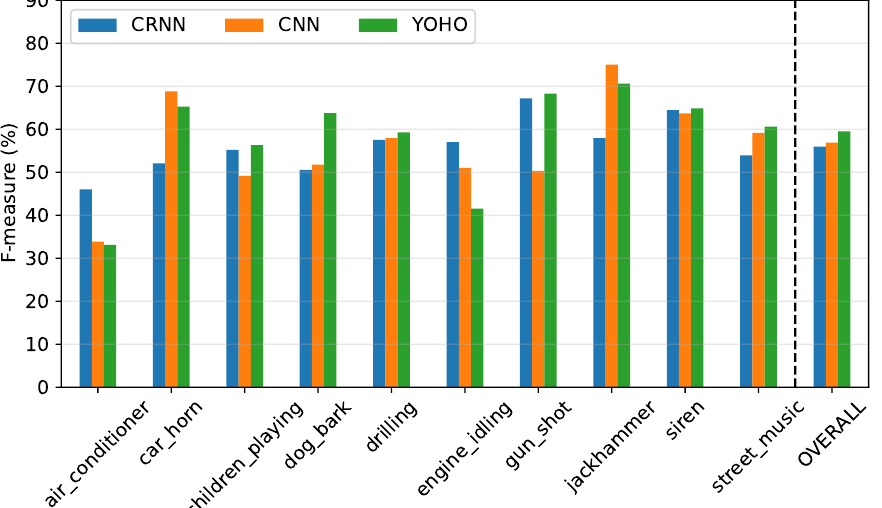
Figure 3. Segment-based F-measures for each class on the Urban-SED dataset calculated using segment-size of 1 s.